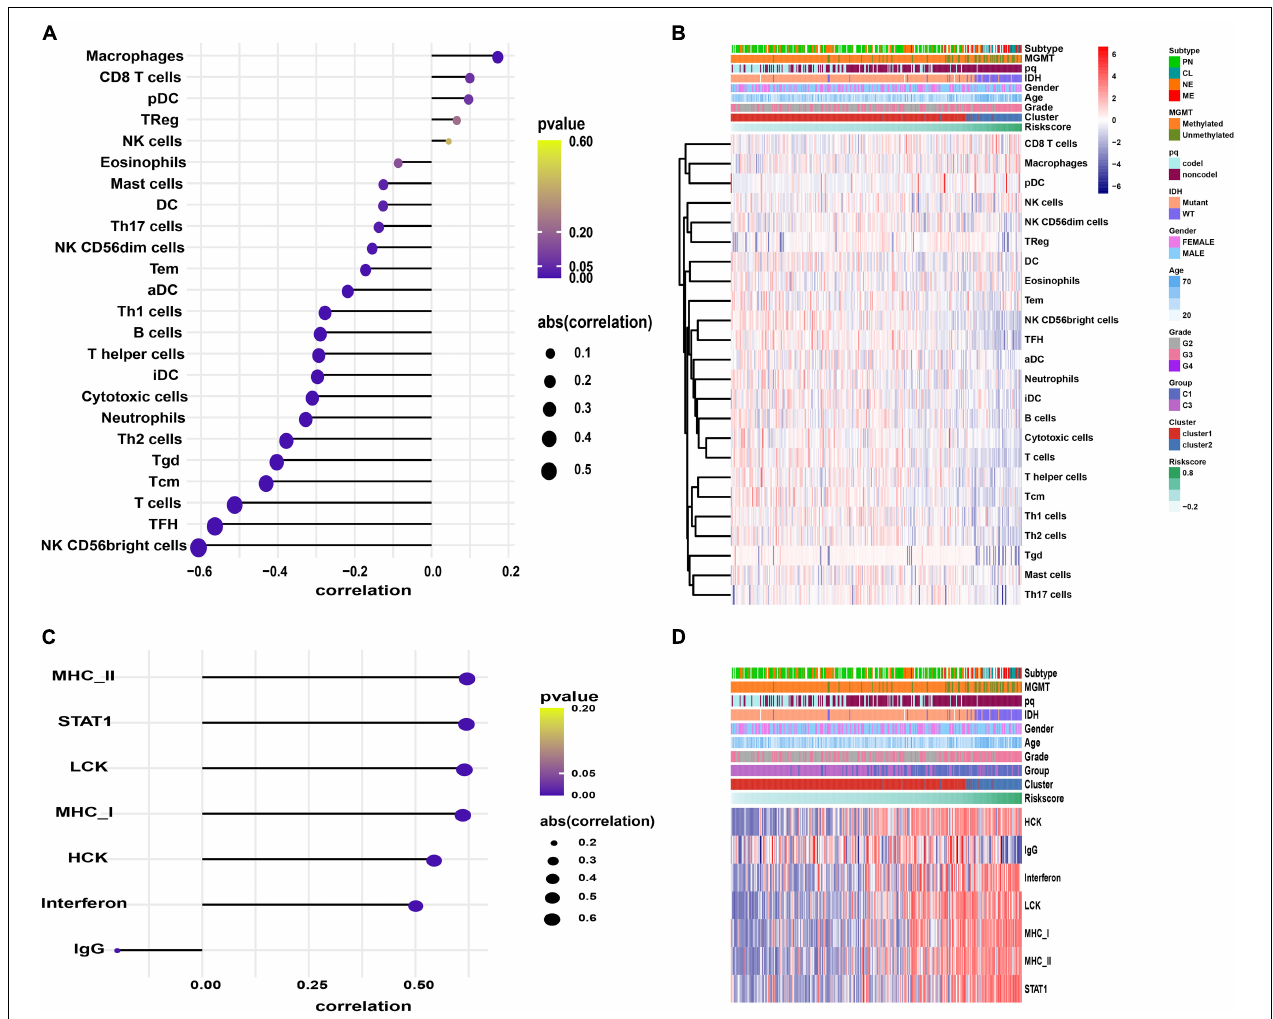
FIGURE 7 | The GSVA results. (A,C) Correlograms showing the correlation between immune cell infiltration, inflammation activities, and risk score. (B,D) Heatmaps displaying the activities of immune cells panel (B) and inflammation panel (D)